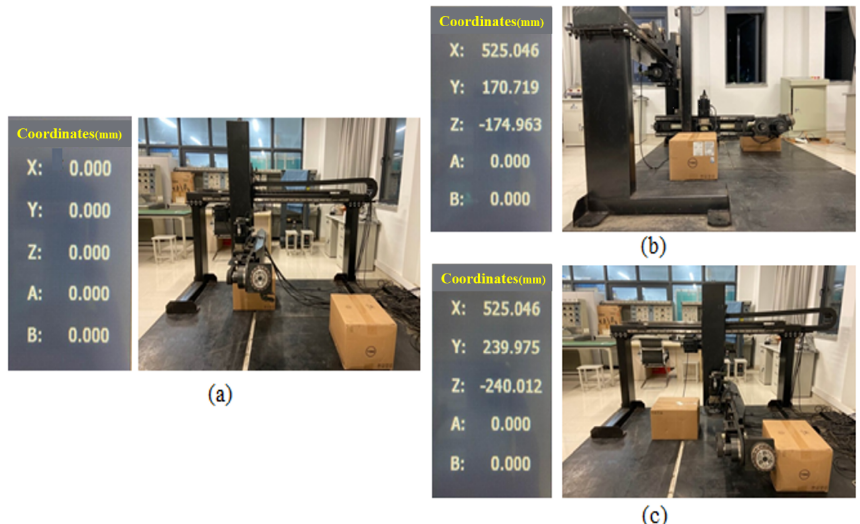
Figure 13. The obstacle-avoidance process of the robot arm: (a) the starting state, (b) the obstacle-avoidance state, and (c) the ending state.